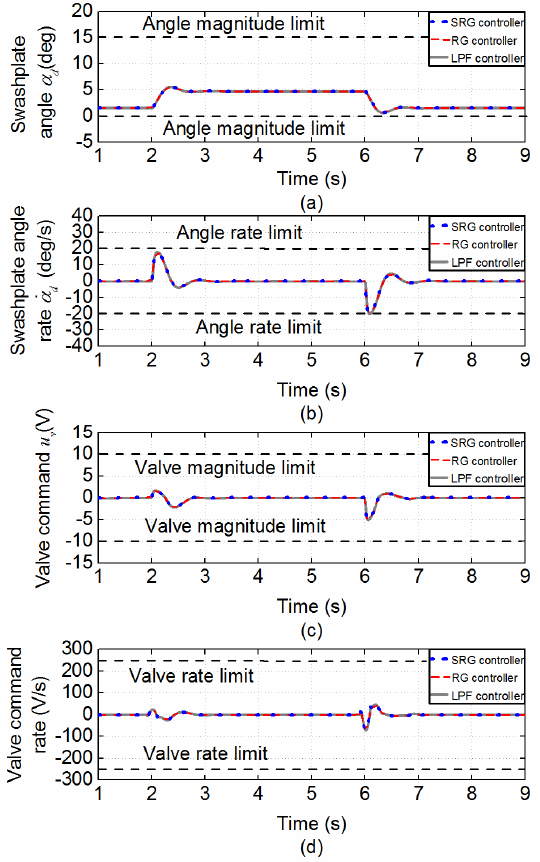
Figure 6. Actuator control inputs of the three controllers for a step trajectory from 10 bar to 30 bar. ( a ) The swashplate angle. ( b ) The swashplate angle rate. ( c ) The valve command. ( d ) The valve command rate.